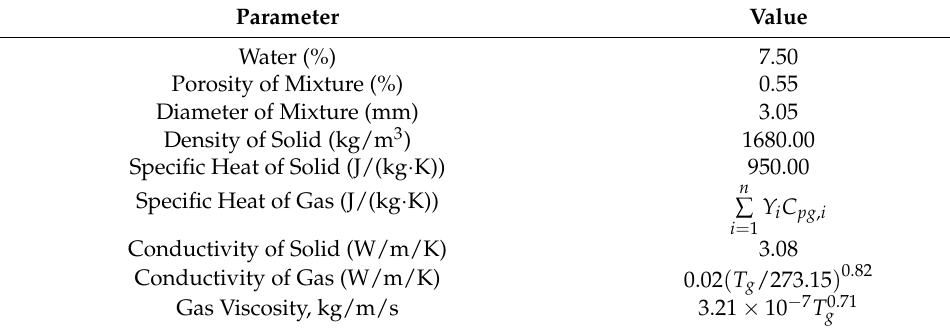
Table 4. Dimensions and parameter values used for the numerical